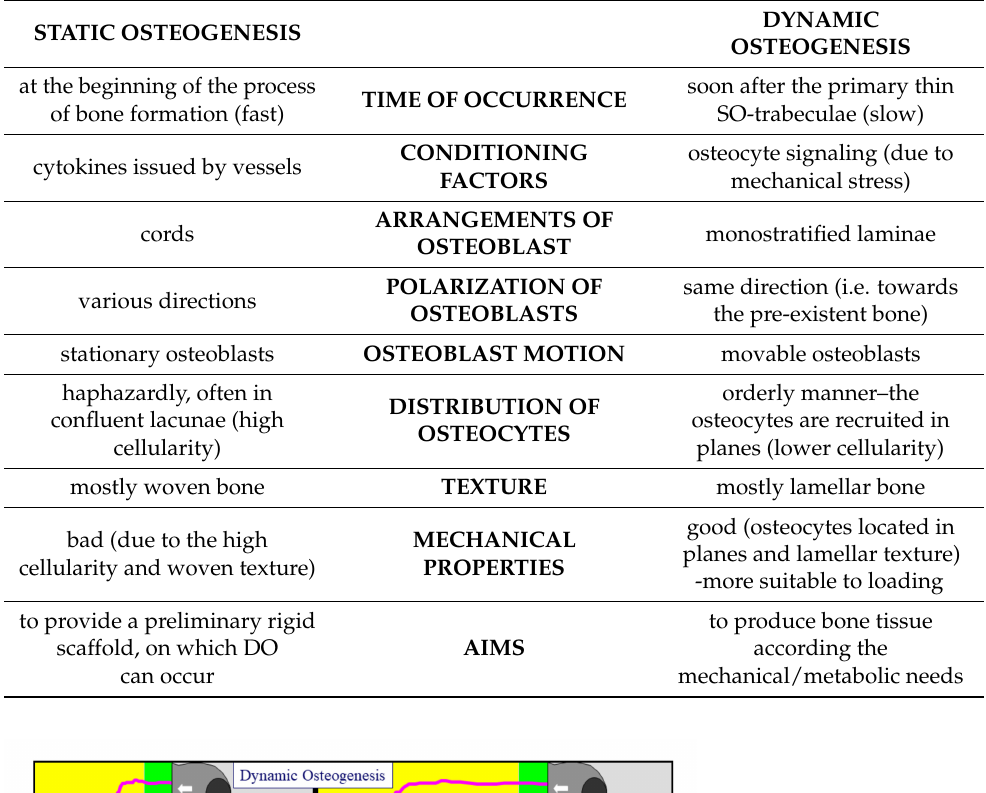
Table 1. Main morpho-functional differences between SO and DO.